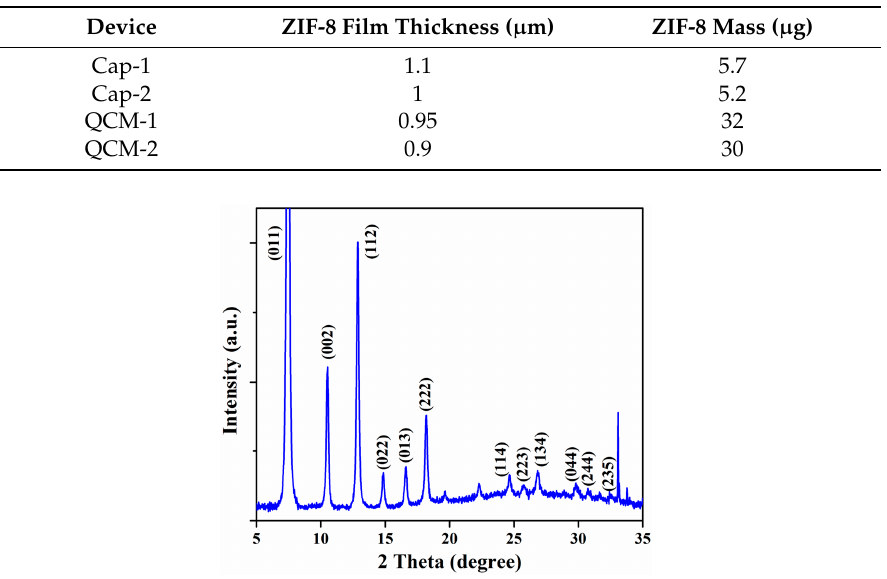
Figure 3. SEM micrographs before and after coating of the ZIF-8 film onto the sensing substrates obtained at a 45° tilt angle. ( a ) Uncoated interdigitated electrode (IDE) capacitive substrate. ( b ) Blank QCM substrate coated. ( c ) IDE capacitive substrate coated with ZIF-8 film. ( d ) QCM substrate coated with ZIF-8 film. Table 1. Comparison of thickness and mass of ZIF-8 films deposited on the sensors.